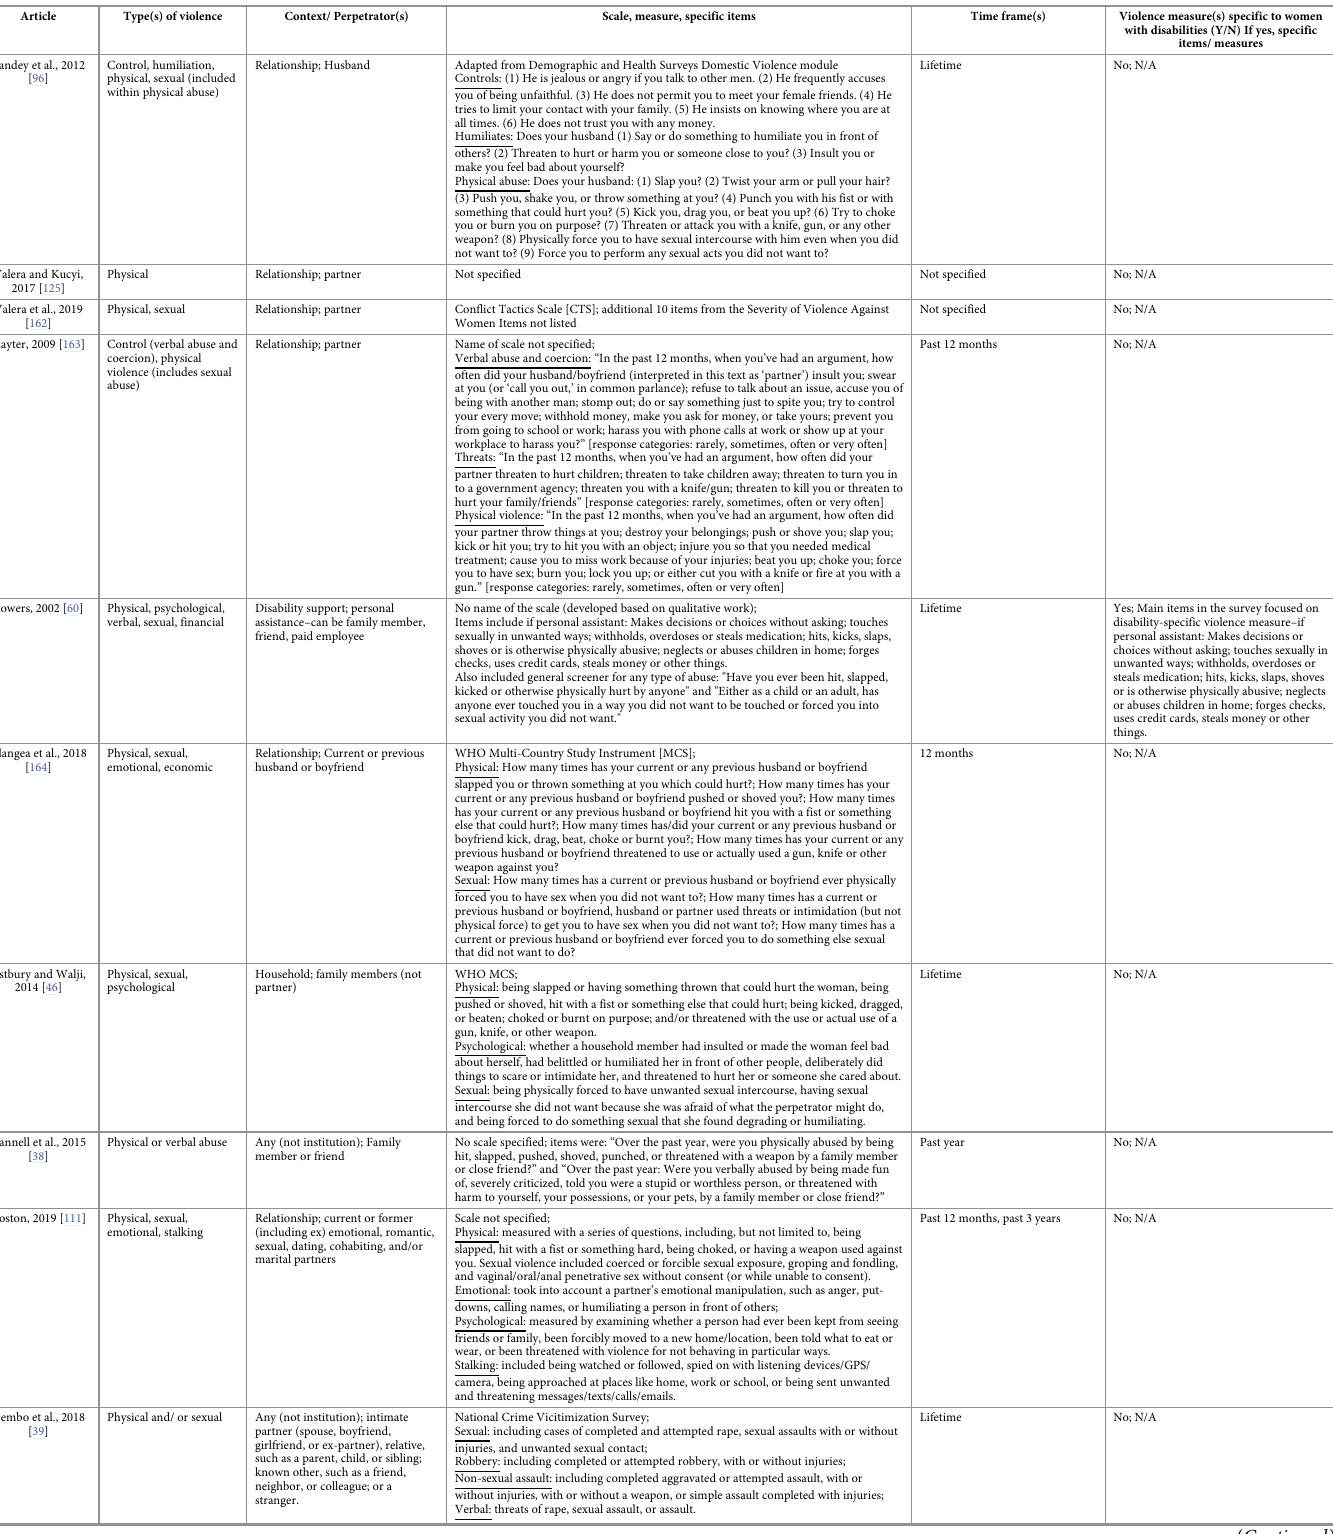
Table 3. Measurement of